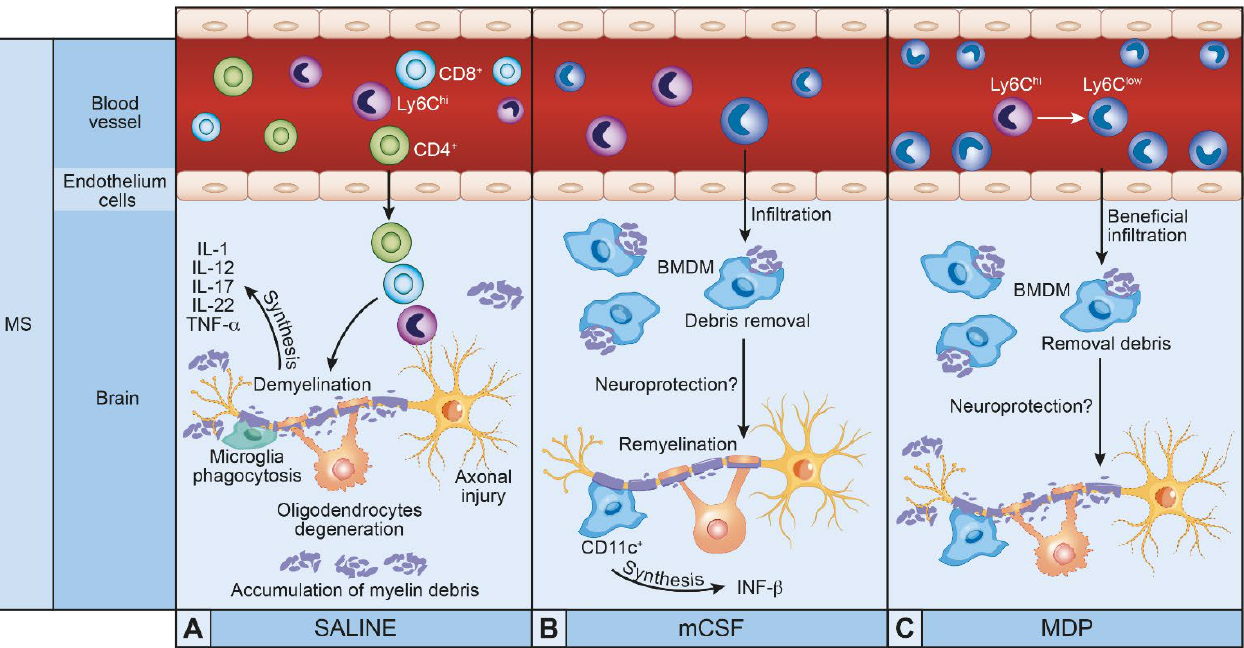
Figure 1. Therapeutic molecules modulating innate immune cells in multiple sclerosis (MS): ( A ) Cellular responses in the presence of myelin debris and hyperactivation of innate immune cells against myelin leading to oligodendrocyte degeneration. ( B ) Injections of macrophage colony stimulating factor (mCSF) trigger microglial proliferation and peripheral infiltration, improving myelin debris removal and remyelination and regeneration of oligodendrocytes. ( C ) Injections of muramyl dipeptide (MDP) induce the switch of monocytes Ly6C hi to Ly6C low , improving myelin debris